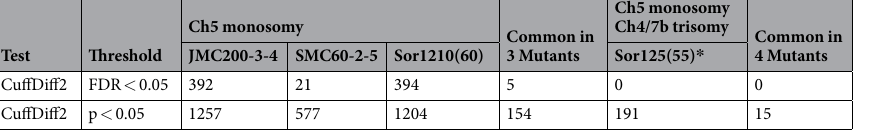
Table 2. Number of differentially expressed genes and genes in common in mutants JMC200-3-4, SMC60-2-5, Sor1210(60) and Sor125(55). * Differential expression was assessed by t test.